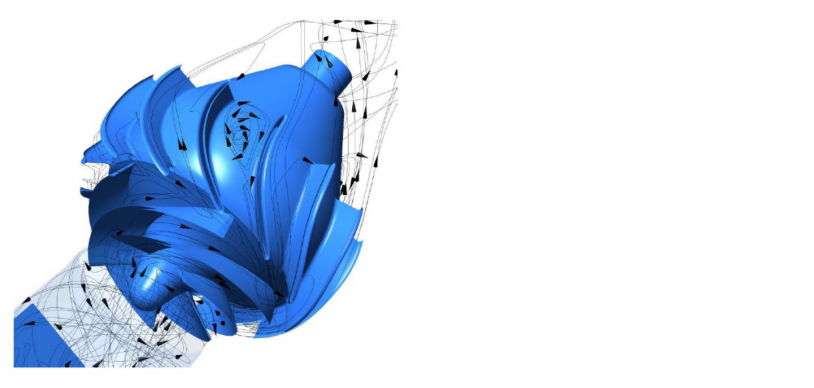
Figure 18. Suction and discharge recirculation caused by excessive swirl at the pump inlet